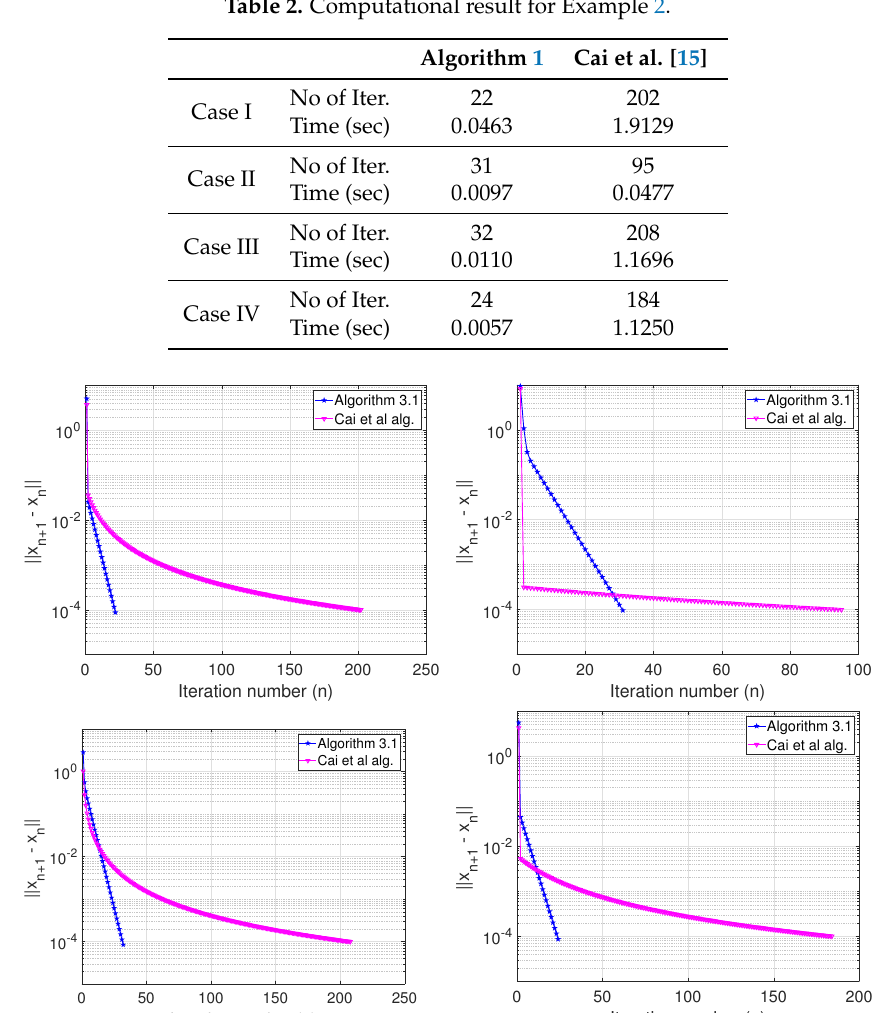
Table 2. Computational result for Example 2.